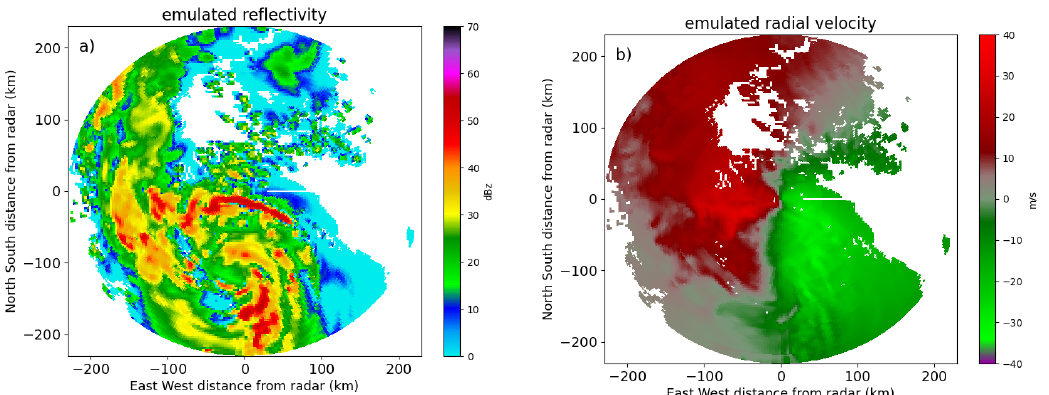
Figure 5. The emulated ( a ) reflectivity and ( b ) radial velocity of Hong Kong Tate’s Cairn weather radar at 0.9° elevation at 18:00 UTC 18 August 2020. Coordinate point [0, 0] is the location of the